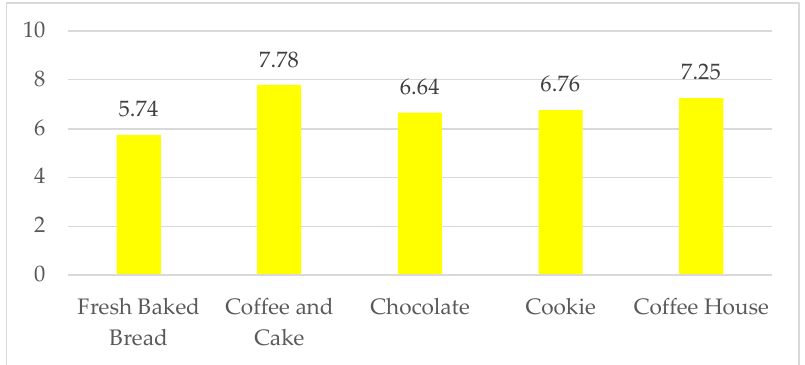
Figure 9. Explicit evaluation of individual aromas on a scale under laboratory conditions.